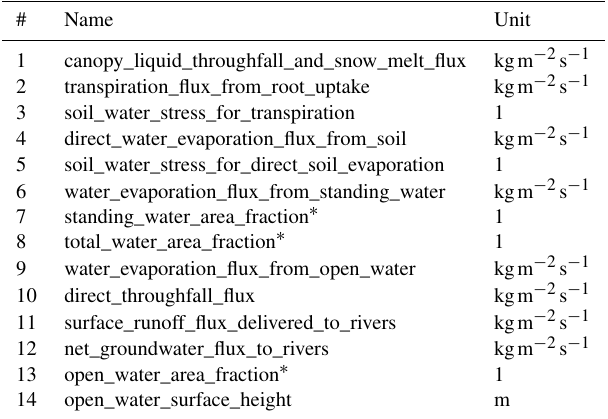
Table 1. Prescribed interface variables defining what must be trans- ferred between the framework